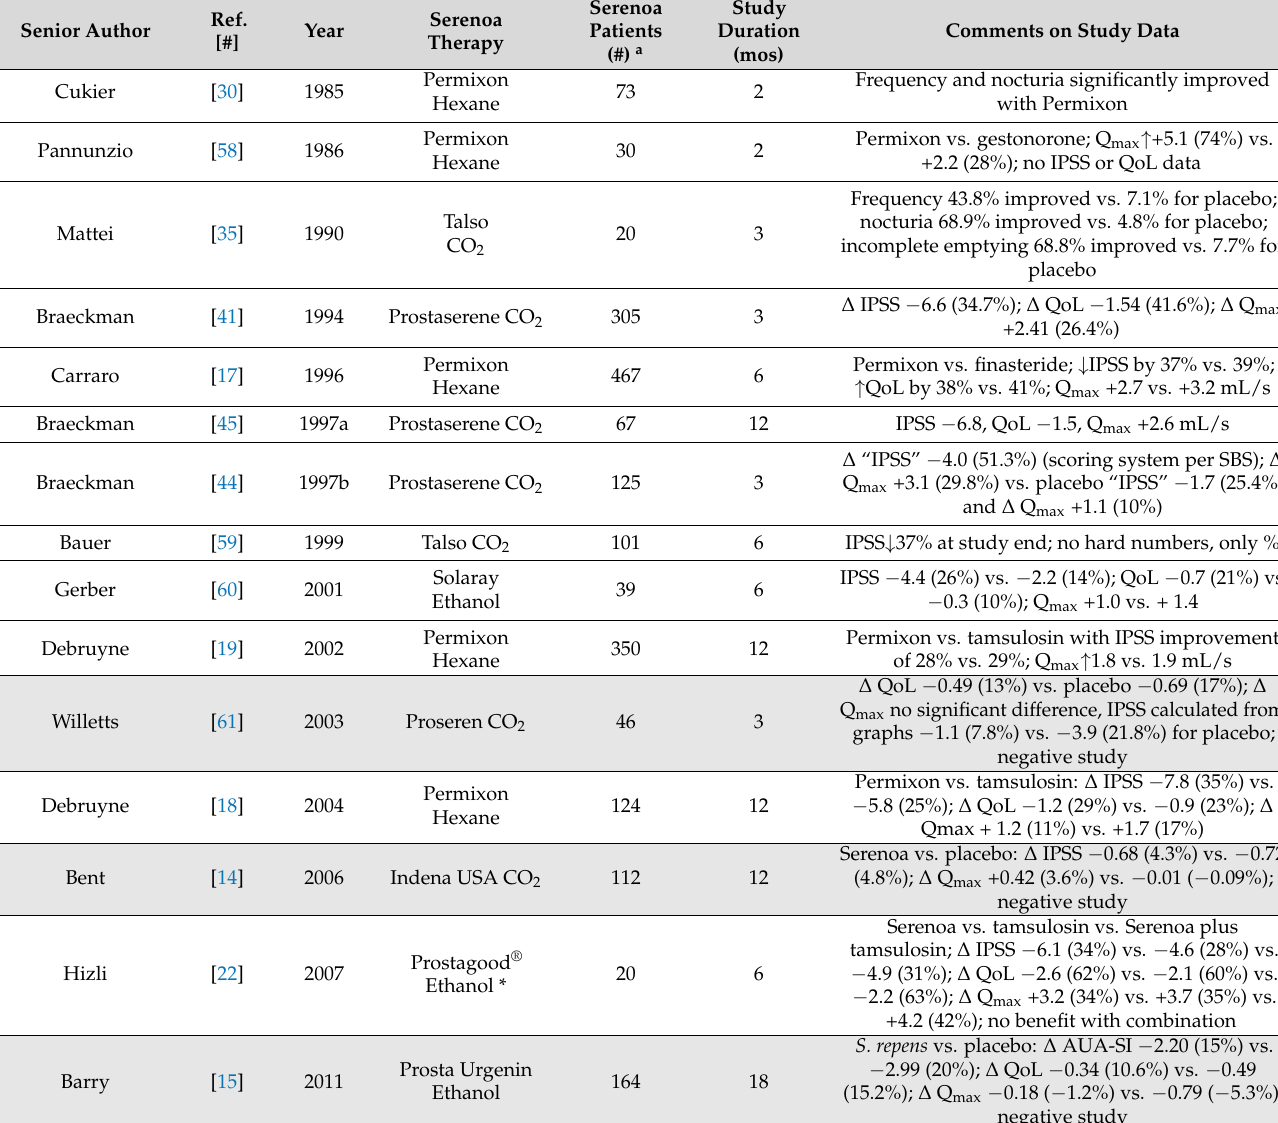
Table 2. Evaluable studies in Cochrane 2012. Of the 15 out of 35 studies considered evaluable, only 3 (shaded in gray) presented negative findings of LSESr efficacy. Patient numbers were active patients at study